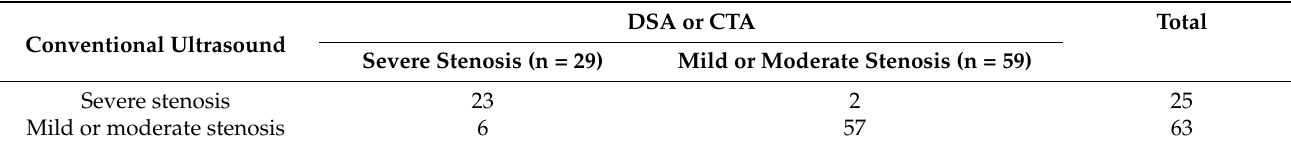
Table 2. The diagnostic value of conventional ultrasound in carotid stenosis.